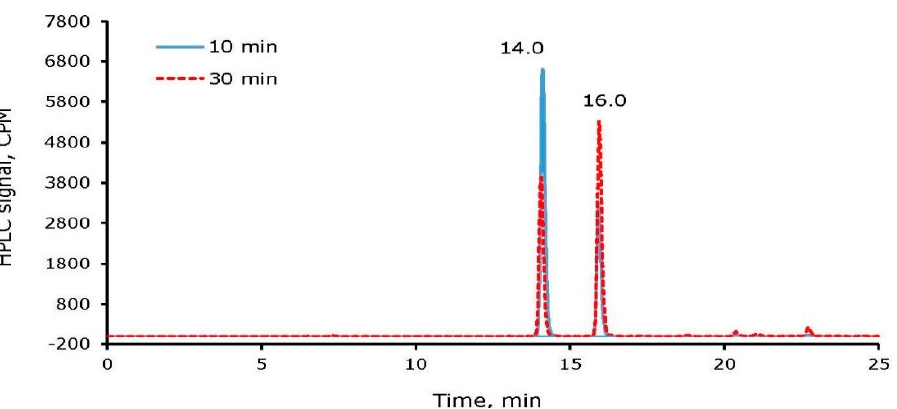
Figure 5. The percentage of 125 I-cRGDyK and 125 I 2 -cRGDyK after incubation of the reaction mixture for 10 and 30 min, respectively.